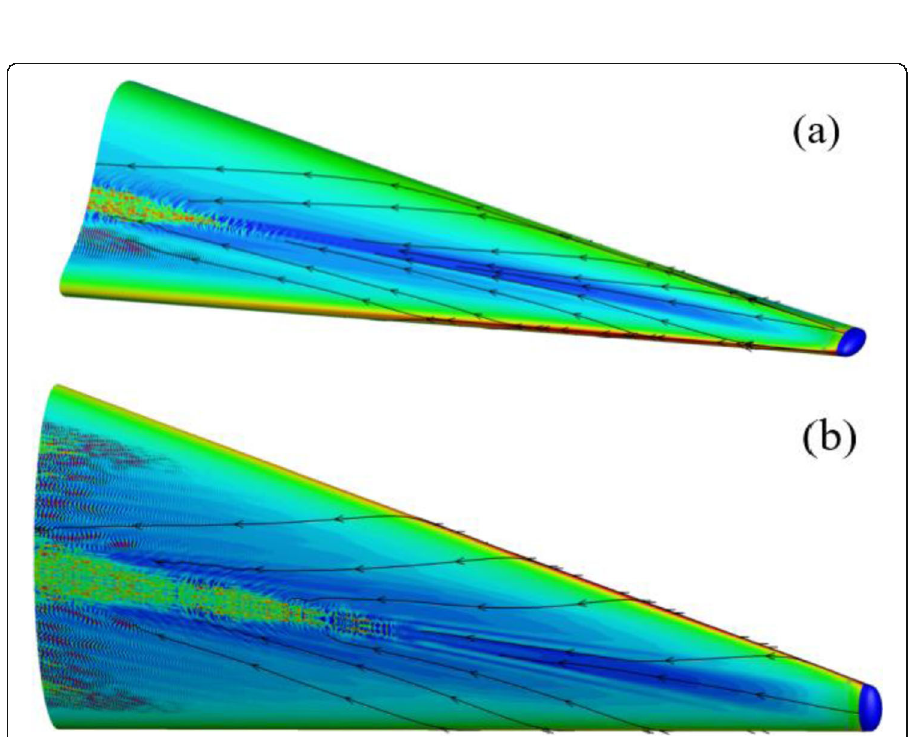
Fig. 9 Heat flux coefficient and streamlines on the surface of the